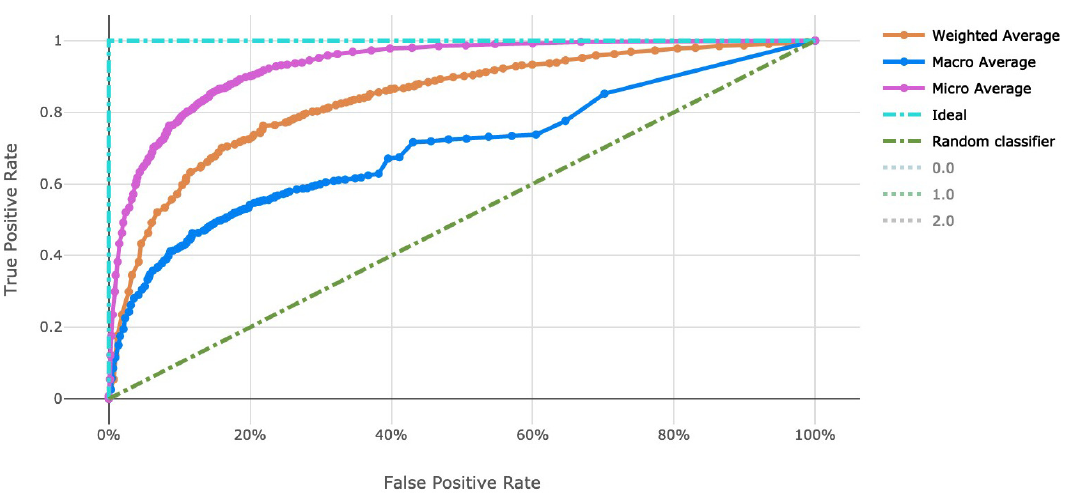
Figure 4. Receiver operating characteristic curve of the clearance rate